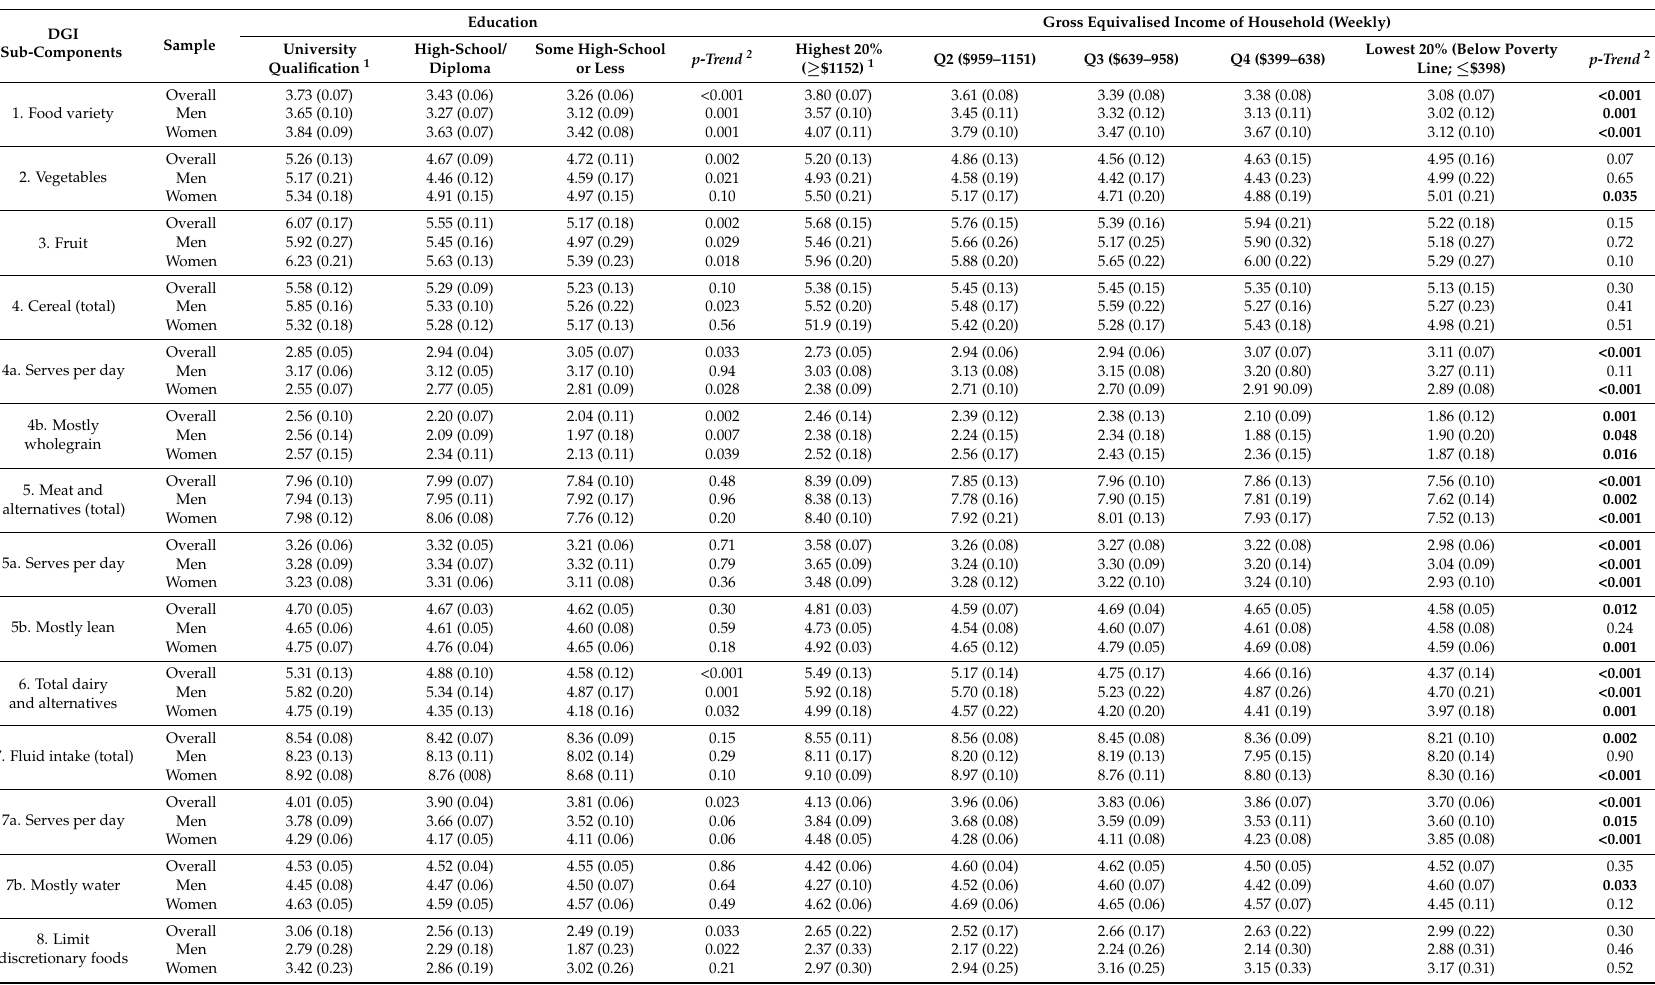
Table 2. Dietary Guideline Index (DGI) sub-components by education and income in men ( n = 2356) and women ( n = 2519) from the 2011–13 Australian National Nutrition and Physical Activity